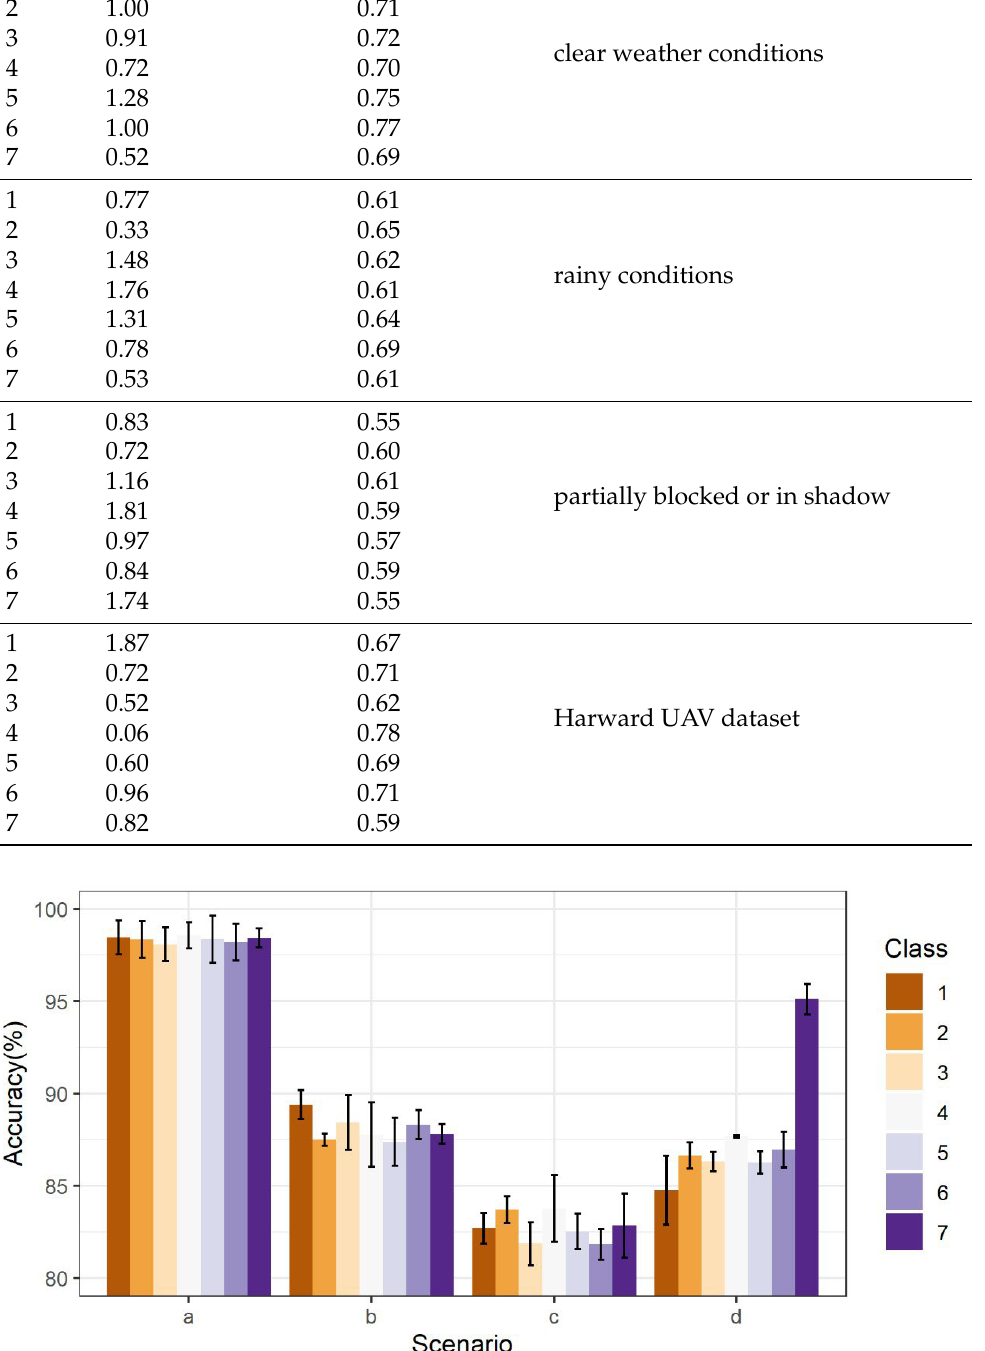
Figure 12. Accuracy of classification by class in different scenarios: ( a ) clear weather conditions; ( b ) rainy conditions; ( c ) partially blocked or in shadow. ( d ) shows the classification result from the Harward UAV dataset